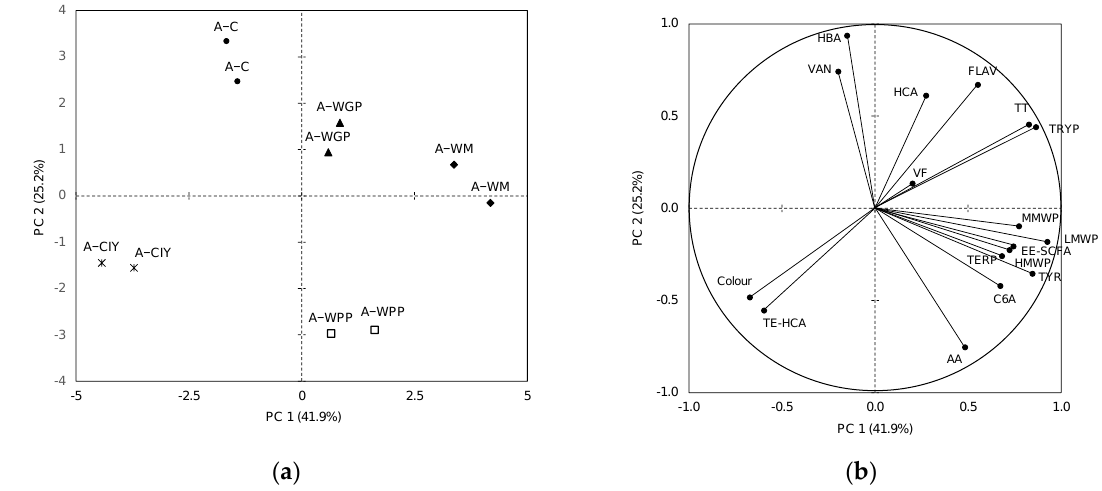
Figure 1. Principal component analysis: ( a ) distribution of the Albillo wines; ( b ) loadings of the variables. C: control wines, WM: wines with the addition of PSs extracted from white must, WGP: wines with the addition of PSs extracted from white grape pomace, WPP: wines with the addition of wine purified polysaccharide rich in RG-II, CIY: wines with the addition of commercial inactivated yeasts. Abbreviations of compounds in Materials and Methods